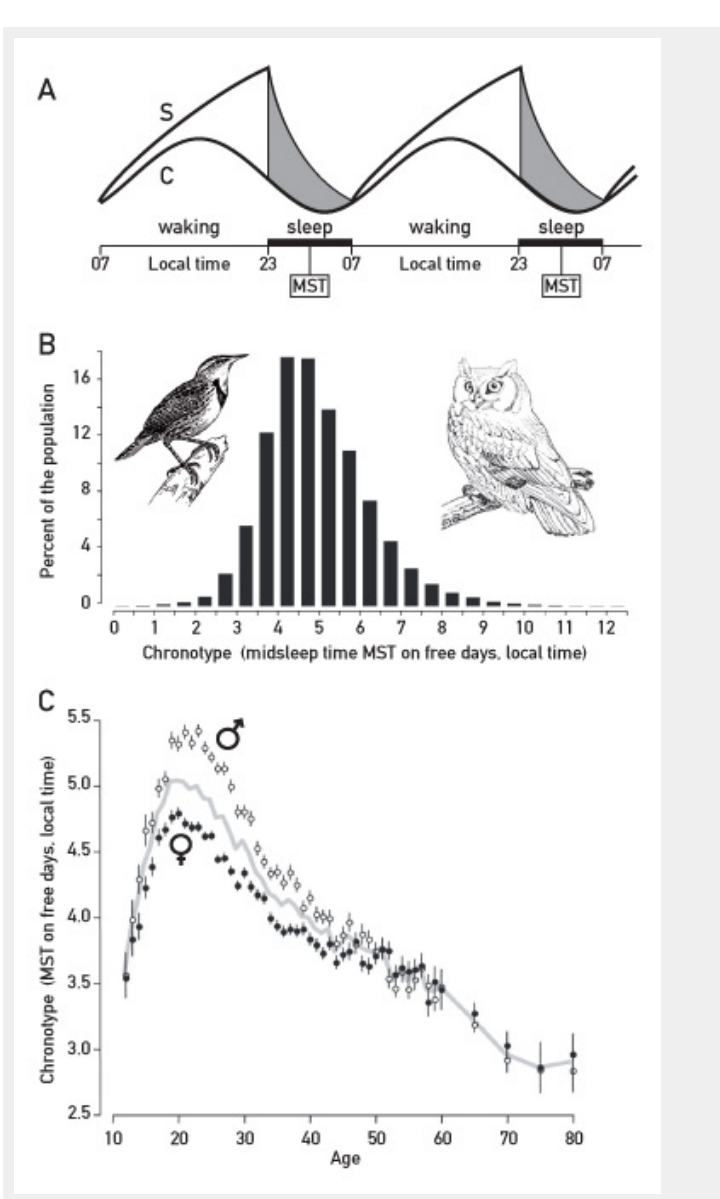
Sleep-wake cycles and human chronotypes. A. Sleep-wake signals are driven by the circadian clock (C) and a sleep homeostat (S). The sleep homeostat resembles an hourglass timer. Sleep pressure steadily builds up after waking until it is so strong that the individual falls asleep. While sleeping (grey zone / black bar on X- axis), sleep pressure diminishes back to the base level. The sleep homeostat is coupled to the circadian clock under normal conditions, but in some individuals the two time keepers can become disconnected from each other after having been exposed to an extended period without external time cues (see text). MST = midsleep time. This scheme was adapted from: Daan S, Beersma DG, Borbely AA. Timing of human sleep: recovery process gated by a circadian pacemaker. Am J Physiol. 1984;246(2 Pt 2):R161–83 [42] and Borbely AA, Achermann P. Sleep homeostasis and models of sleep regulation. J Biol Rhythms. 1999;14(6):557–68 [72], with permission from the Americal Physiological Society. B. Humans can be classified into chronotypes. Those active early during the day and late during the night are known as larks and owls, respectively, in chronobiology parlance. The chronotypes are measured by midsleep time (MST, see panel A) on free days. The values on the X- axis have been corrected for gender and age (see panel C). This scheme has been adapted from [49]. C. Age- and sex-dependent changes in chronotypes. Midsleep time (MST) on free days (chronotype) increases and then decreases with age. In teens and young adults, the late chronotype can engender a social jetlag. In females MST is reached some years earlier as compared to males. This scheme has been adapted from: Roenneberg T, Kuehnle T, Juda M, Kantermann T, Allebrandt K, Gordijn M, et al. Epidemiology of the human circadian clock. Sleep Med Rev. 2007;11(6):429–38 [49], with permission from